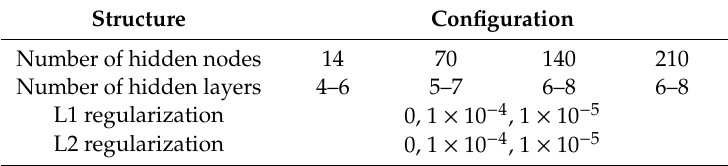
Figure 2. Structural diagram describing deep neural network (DNN) operation. Table 3. Parameters of the training model used to find an optimal structure for retrieving solar